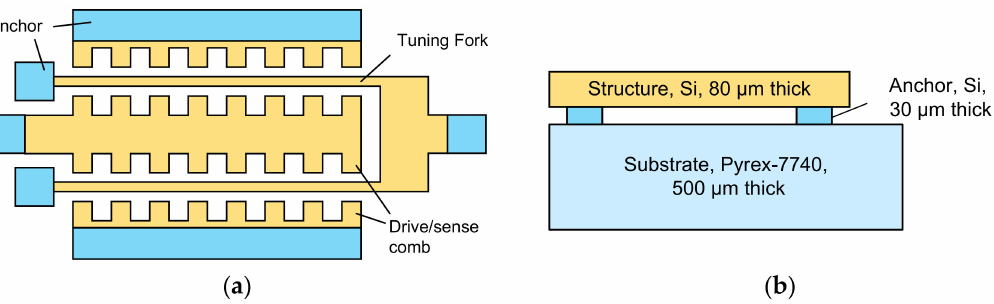
Figure 1. Schematic drawing of the stress test structure. ( a ) Top view; ( b ) the layer stack of the